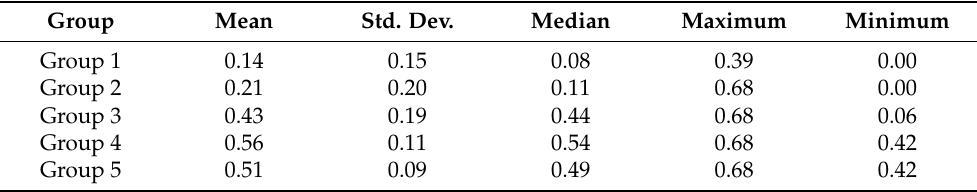
Table 7. Emissions of thermal origin per inhabitant, in tCO 2 /year.